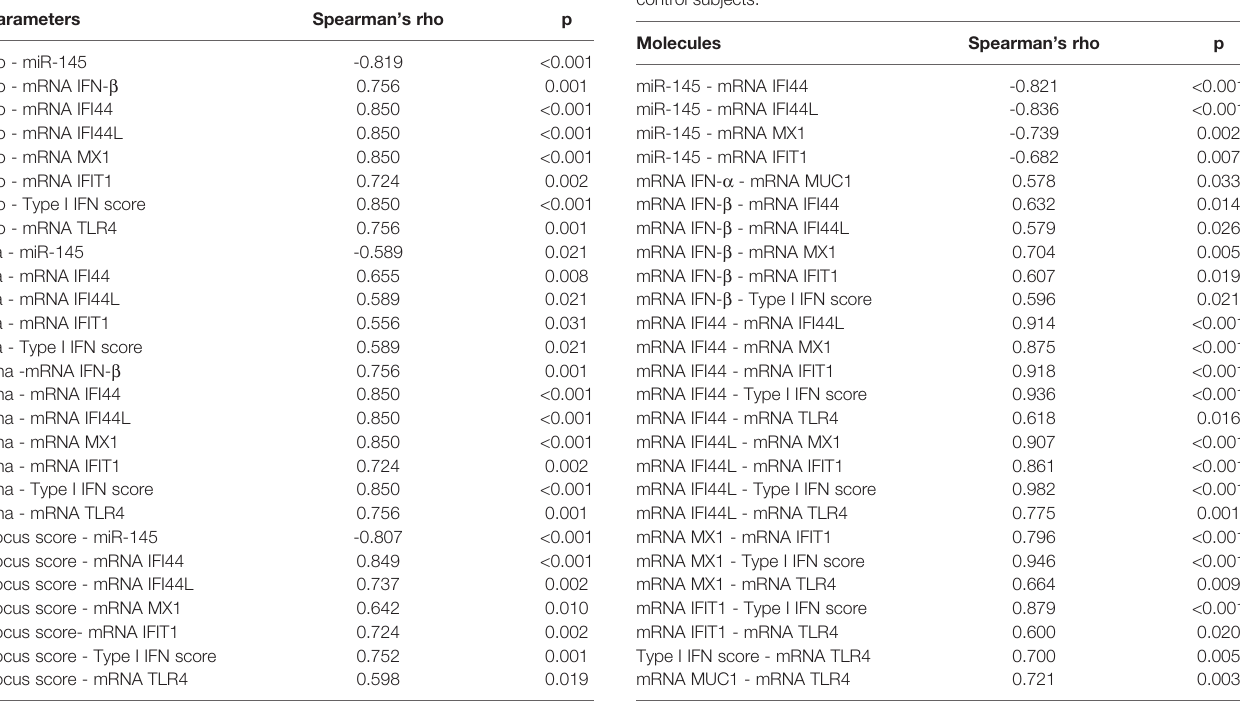
TABLE 3 | Spearman ’ s rank correlation coef fi cients between hsa-miR-145-5p levels and mRNA levels of each analyzed gene in LSG from SS-patients and control